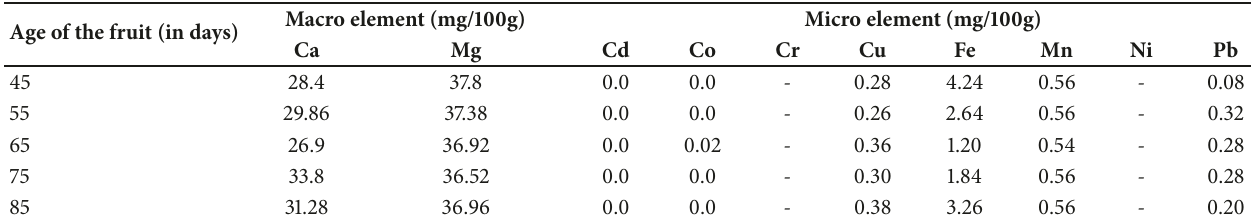
Table 3: Mineral composition of the edible fruit flesh at different maturity levels.